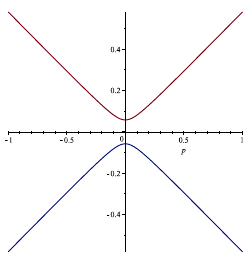
Figure 2. Fermi pockets are presented for the model with Dirac fermions, with m = 0.1 and v = 2. The vertical axis corresponds to radial momentum while the horizontal axis corresponds to the transversal component of